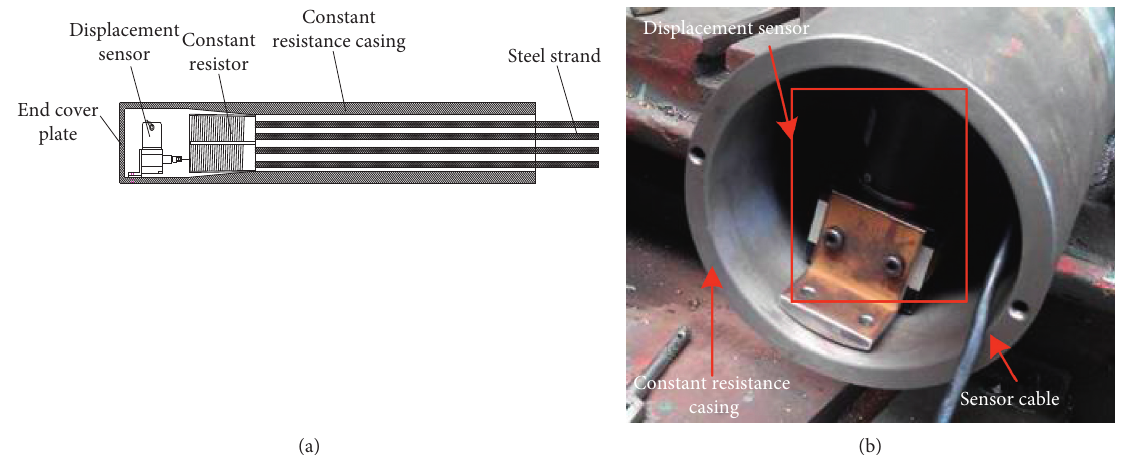
Figure 10: Measuring device for the sliding distance of the constant resistance body.